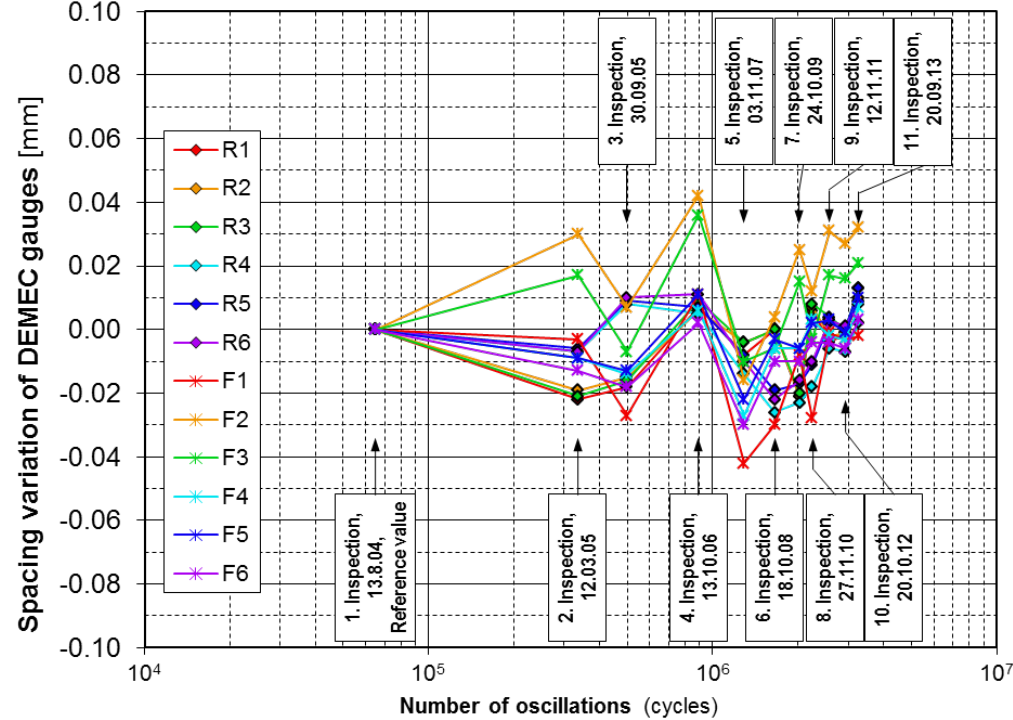
Figure 15. Spacing variation of DEMEC gauge as a function of the number of